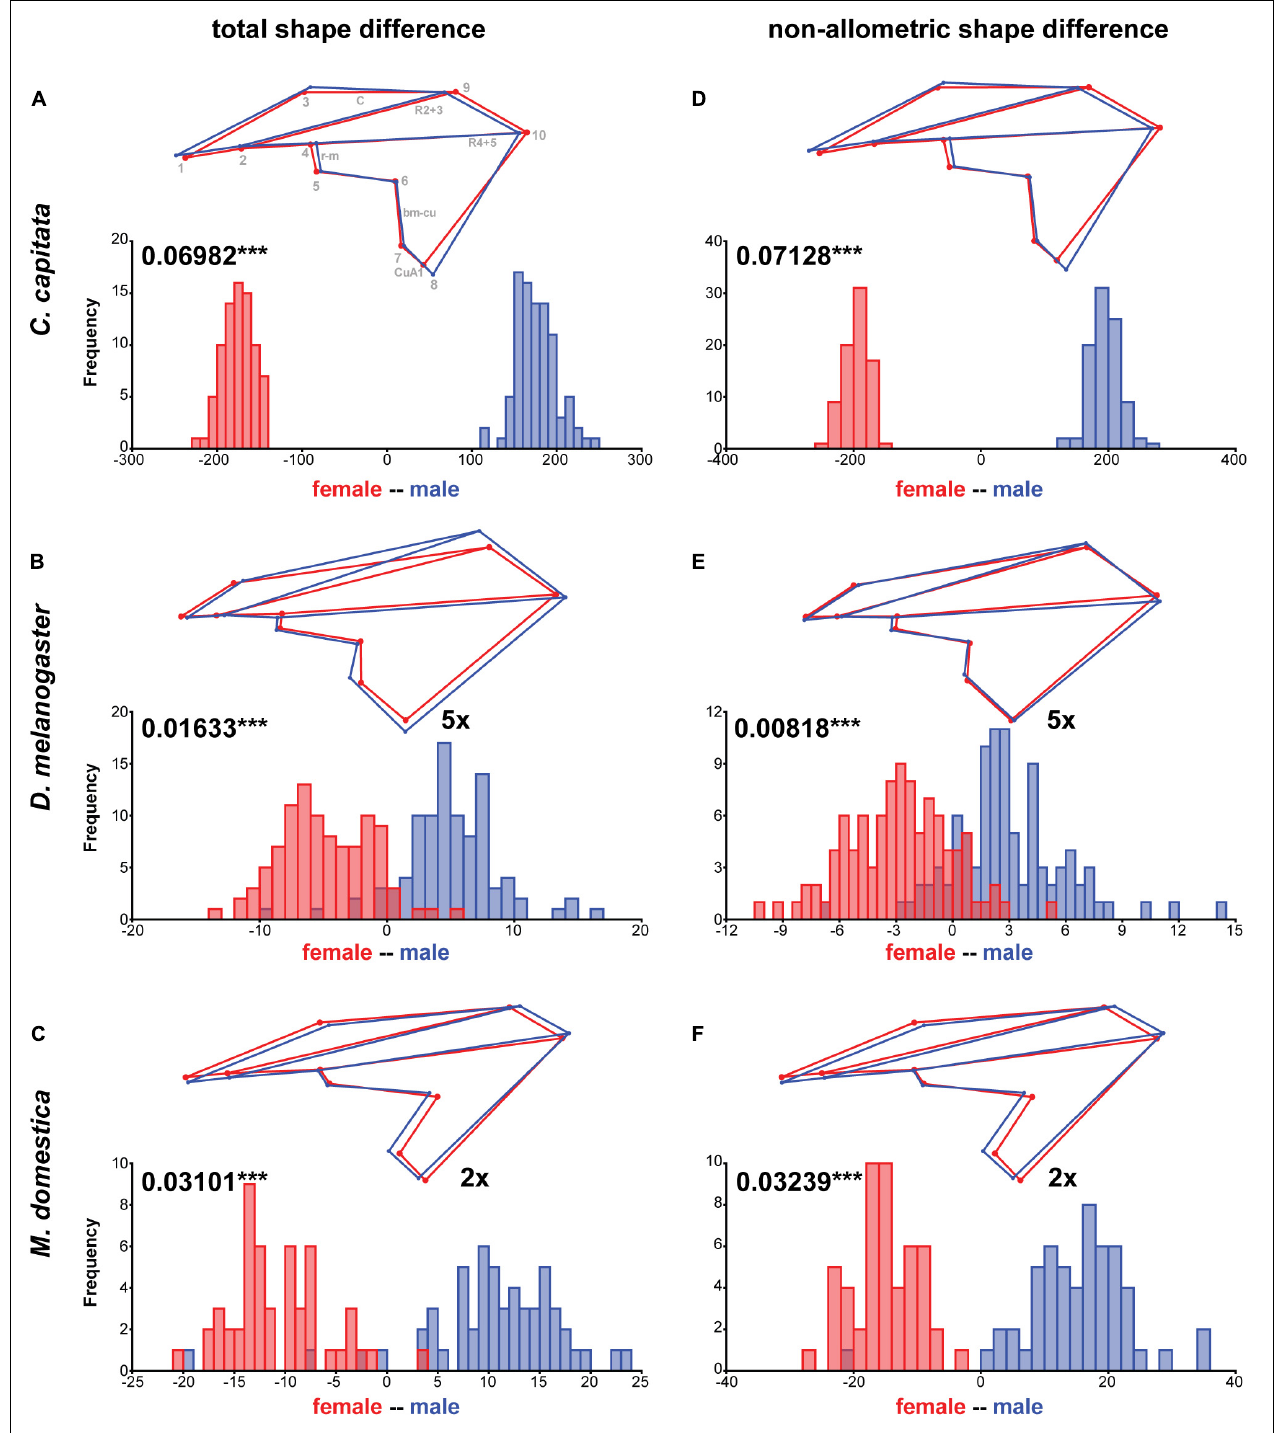
FIGURE 2 | Total and non-allometric sexual shape dimorphism. Summary of discriminant function analyses for total (A–C) and non-allometric (D–F) shape differences between females and males. The wireframes represent differences between female (red) and male (blue) average wing shapes. The scale factor is provided next to the wireframes. The magnitude of sexual shape dimorphism is indicated in units of Procrustes distance with the corresponding p -values based on 1,000 random permutations (*** P ≤ 0.001). Histograms with the distributions of the discriminant scores show shape separation into two distinct groups for each species. See also Supplementary Table 5 for